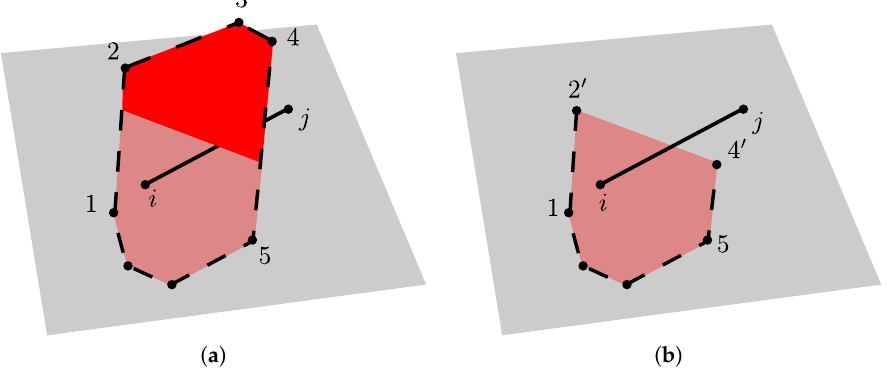
Figure 3. Discretisation of domain boundaries: ( a ) Voronoi facet of Delaunay edge i – j located on the surface of the domain after initial tessellation; and ( b ) modified arrangement used for definition of transport nodes and